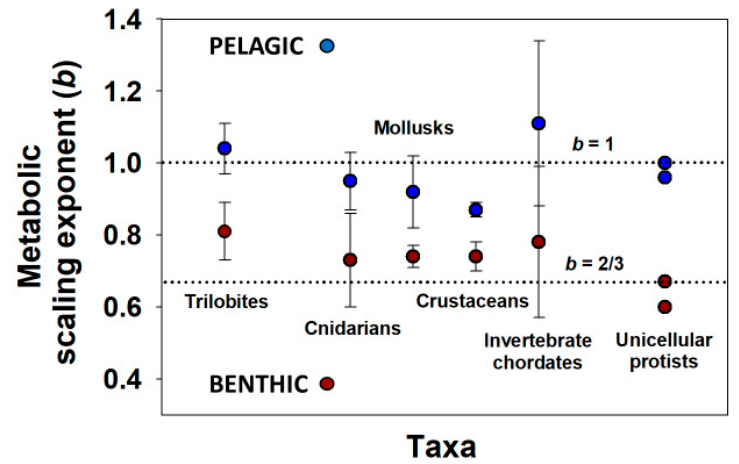
Figure 3. Means ( ± 95% confidence intervals) of intraspecific metabolic scaling exponents ( b ) for various taxa of pelagic and benthic animals and protists. The trilobite b values were estimated using the eye-facet method of [24,31] and cell-size metabolic theory [23,24,27] (data from [72]). The b values for various taxa of invertebrates [80] and for the pelagic protist Didinium nasutum [88] and the benthic protist Stentor coeruleus [89] at two different temperatures are based on actual measurements of oxygen consumption rate, a proxy for metabolic rate. Note that the b values for pelagic species tend to be near 1, whereas those for the benthic species tend to be closer to 2/3. Some of these differences may relate to extensive use of cell multiplication during growth of pelagic species versus extensive use of cell expansion during growth of benthic species, a hypothesis that requires testing (see also text).